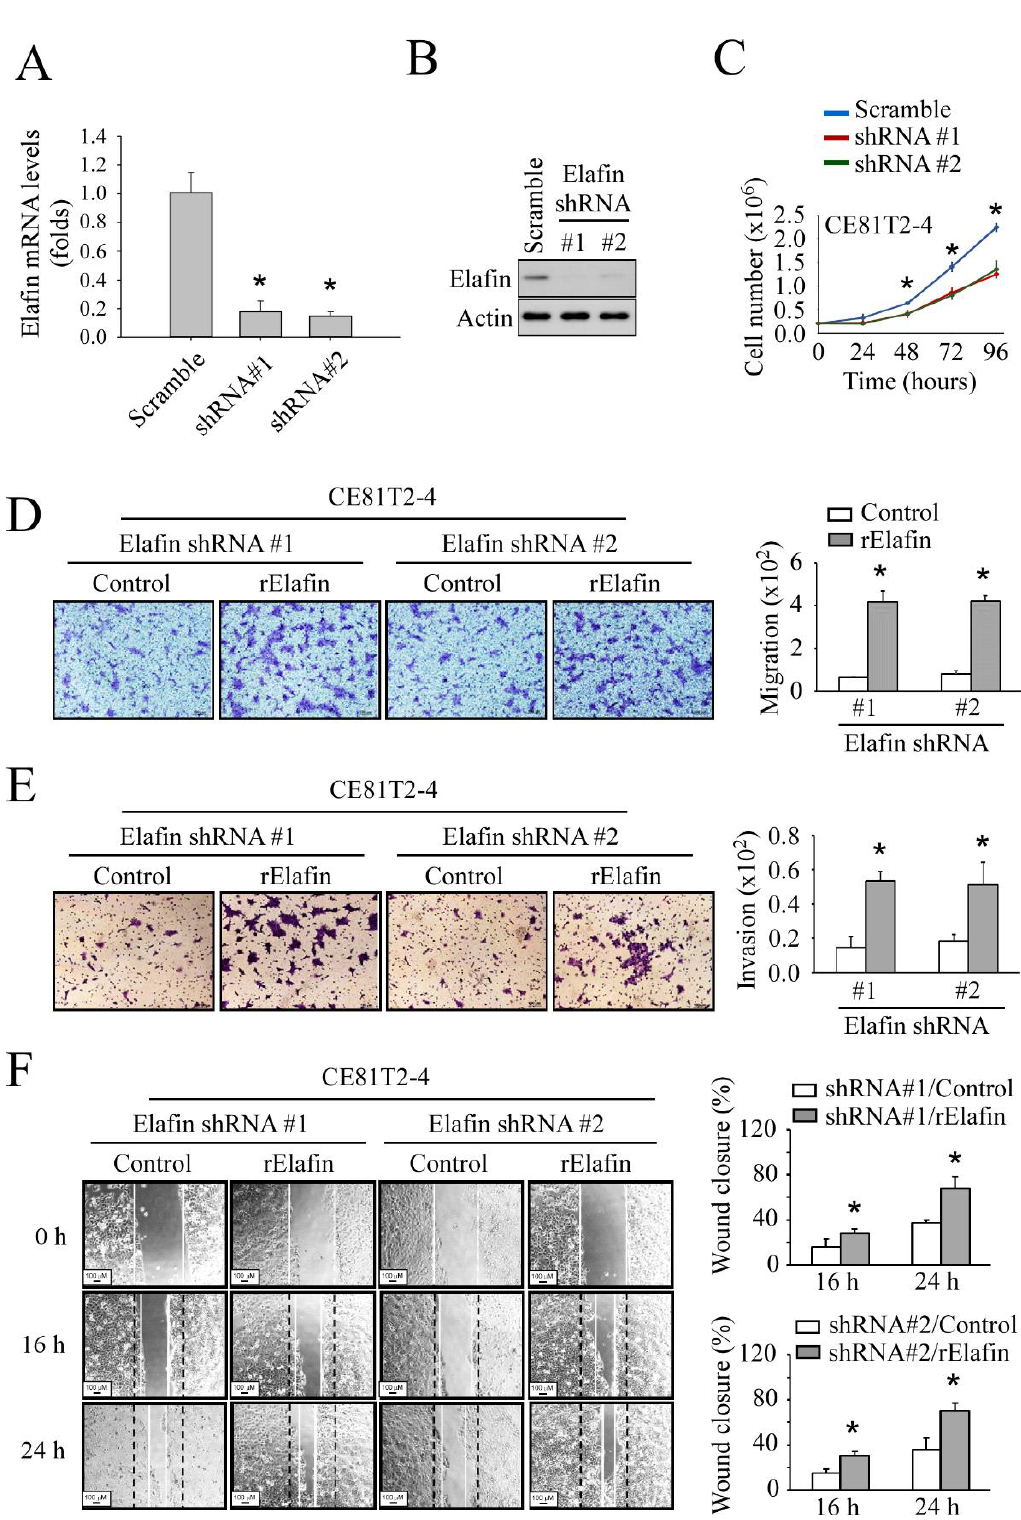
Figure 4. Elafin-specific shRNA suppressed the motility of the CE81T2-4 cell line and rescued by treatment of recombinant Elafin (rElafin) protein: ( A ) suppressed of elafin levels by elafin-specific shRNAs in CE81T2-4; ( B ) suppressed of elafin protein level by elafin-specific shRNAs in CE81T2-4; ( C ) knockdown elafin decreased cell proliferation in the CE81T2-4 cell line; ( D ) rescue migration ability of elafin-knockdown in the CE81T2-4 cell line after treatment with rElafin; ( E ) rescue invasion ability of elafin-knockdown in the CE81T2-4 cell line after treatment with rElafin; ( F ) rescued wound-healing ability of elafin-knockdown in the CE81T2-4 cell line after treatment with rElafin. * indicates p < 0.05 when compared to the relative control.